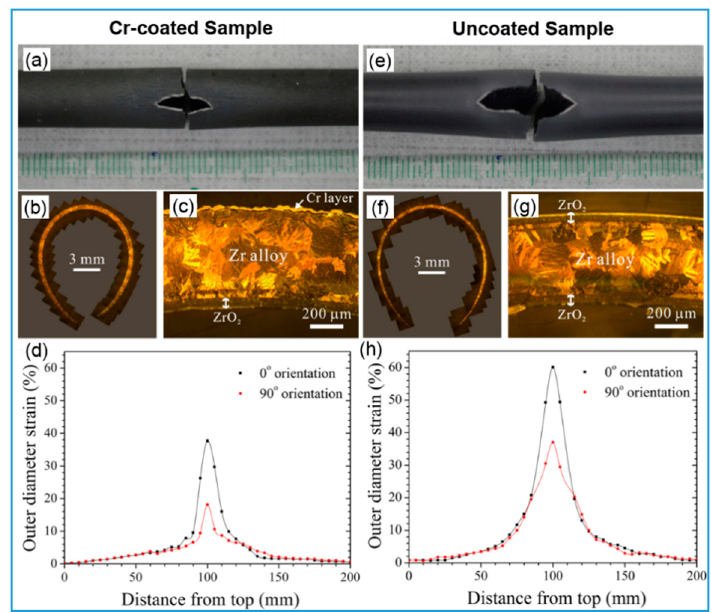
Figure 13. Results of the comprehensive LOCA test on the single-rod Cr-coated Zr alloy cladding (containing Al pellet) : comparsions in the rupture mophology ( a ), residual cladding thickness ( b ) and outer diameter strain ( c ), respectively, between Cr-coated and uncoated samples. Reproduced from the work in [64] with copyright permission from Elsevier.